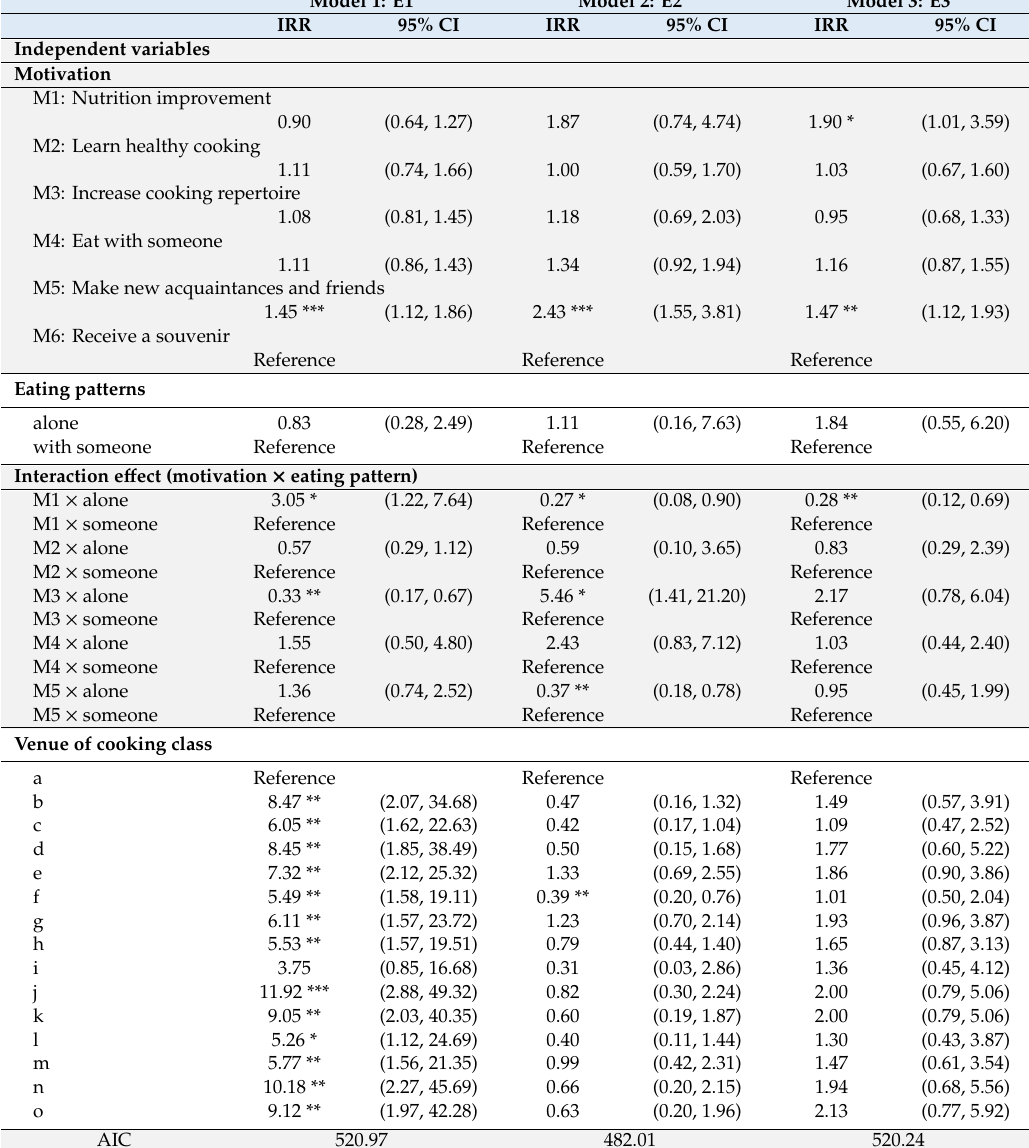
Table 2. The association between participants’ motivation and their perceived e ff ects. Model 1: E1 Model 2: E2 Model 3: E3